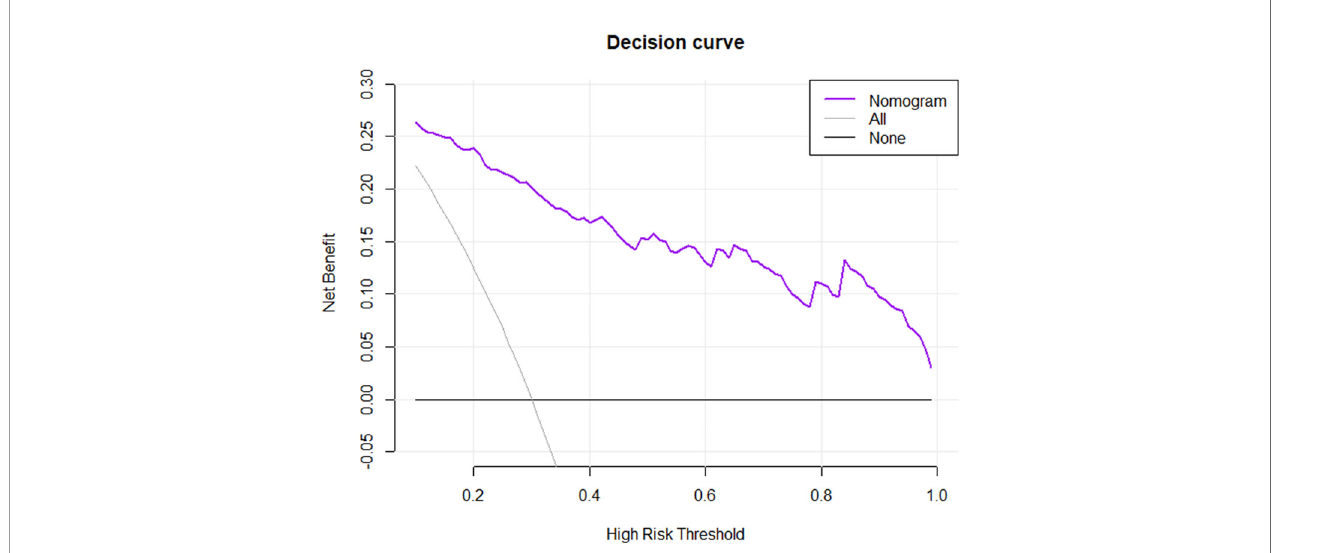
FIGURE 4 | Decision curve analysis for the nomogram in predicting the presence of MVI. The net bene fi t was plotted versus the high-risk threshold. The purple line represents the nomogram. The gray and black lines represent the hypothesis that all patients and no patients had MVI presence,